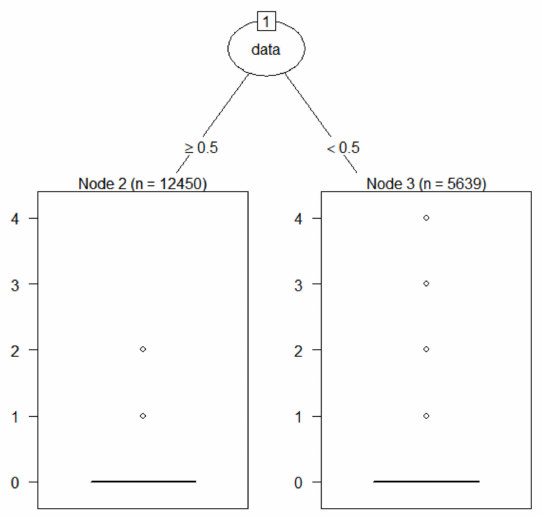
Figure 8. Regression tree plot of